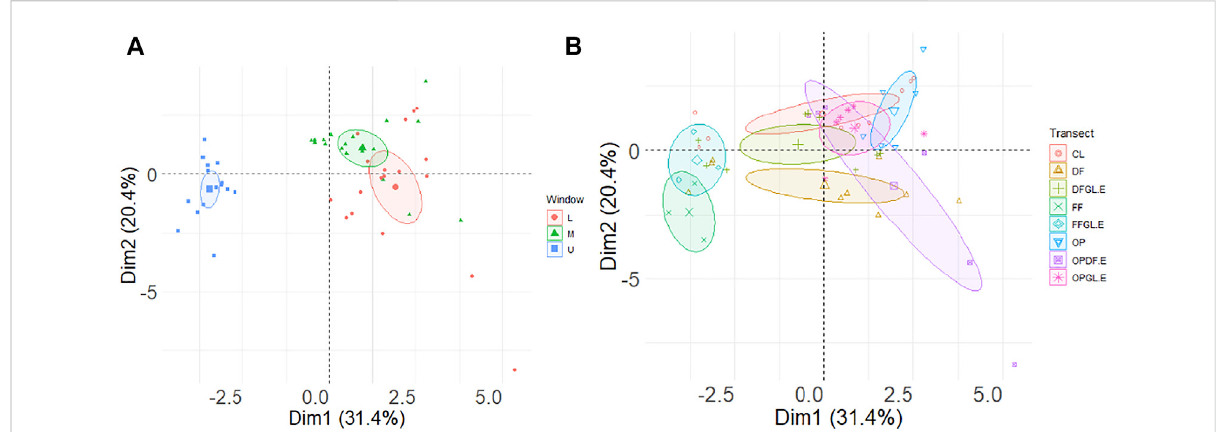
FIGURE 4 Analysis of Principal Components for ESPU, soil ES indicator of nutrient availability. (A) . Window. (B) . Transect. Orotoy river basin. FF, Fragmented Forest; DF,Tropical Dense Humid Forest; GL,Cattle Grassland; OP, OilPalm Plantation. DFGL.E,ecotone DF-GL;OPDF.E, ecotoneOP- DF; OPGL.E, ecotone OP-GL; FFGL.E, ecotone FF-GL. Source: Elaborated by the